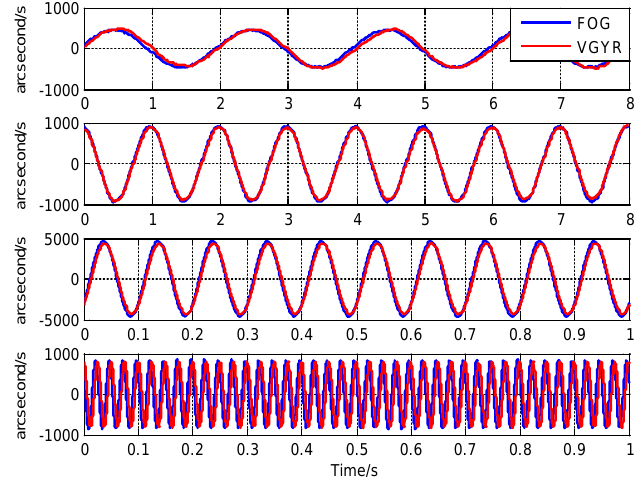
Figure 8. Comparison of measured results between the fiber-optical gyroscopes (FOG) and virtual gyroscopes (VGYR) in time domain.